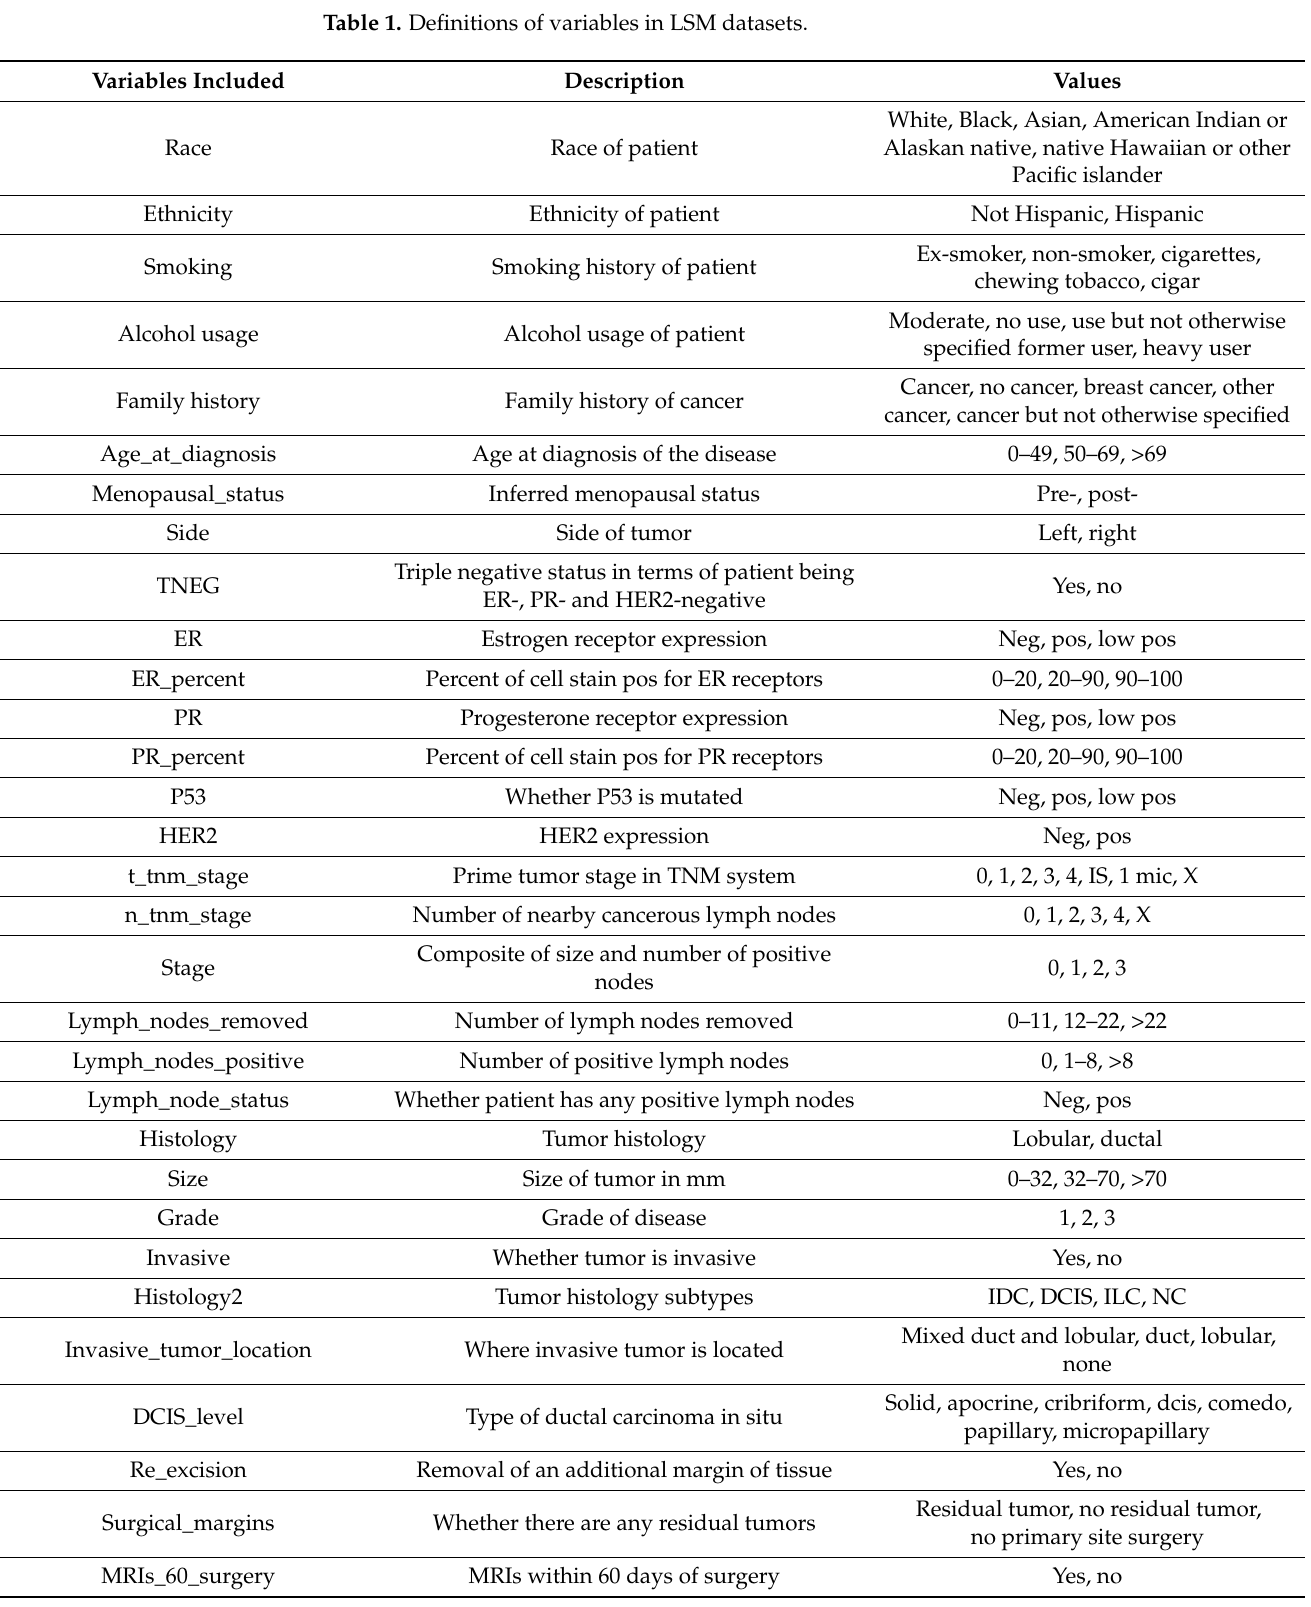
Table 1. Definitions of variables in LSM